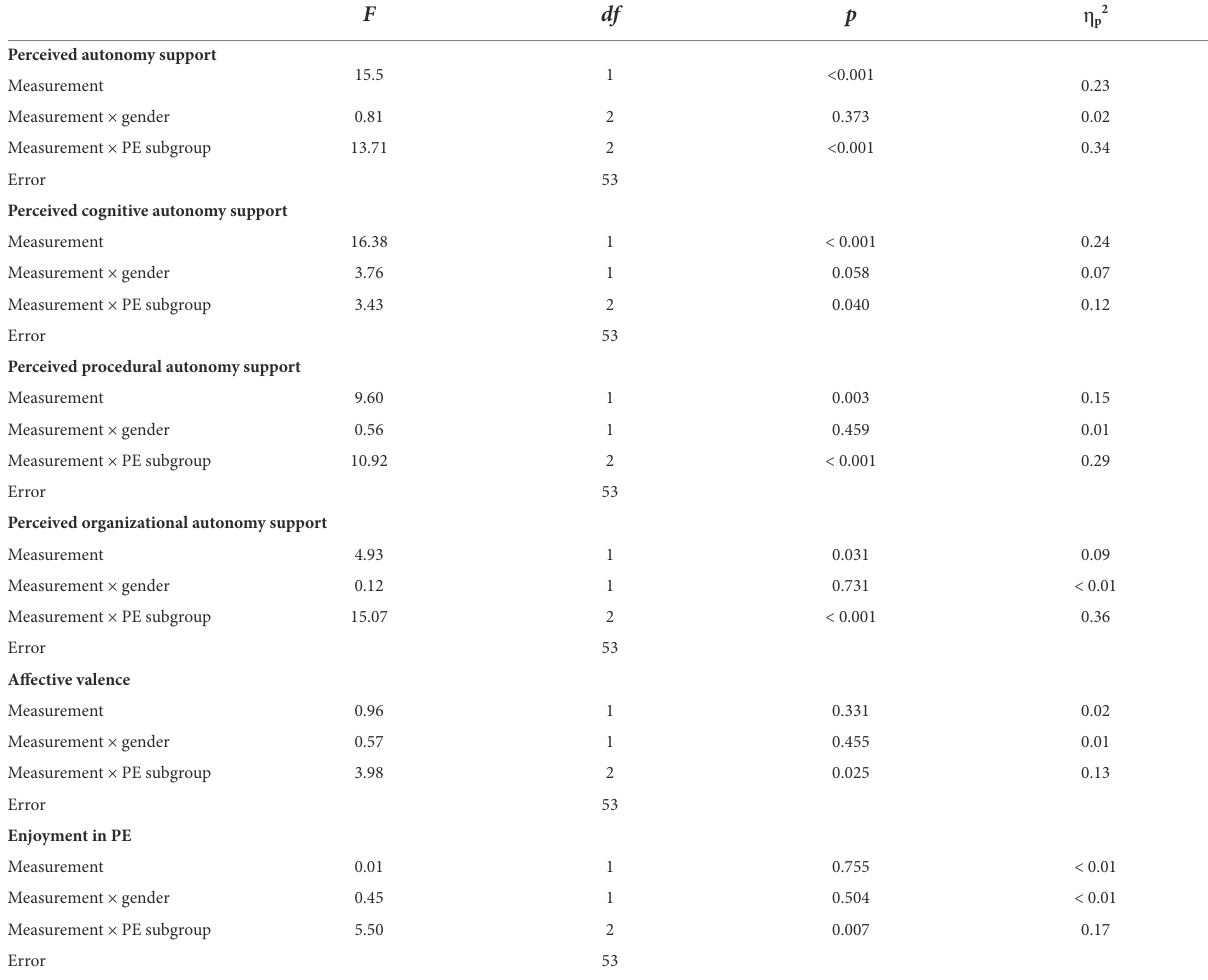
TABLE 2 Within–between interaction results of ANCOVA with two measurements for three PE subgroups (high and low autonomy-supportive, and controlling PE teaching) and the six variables of perceived autonomy support, affective valence, and enjoyment in PE. F df